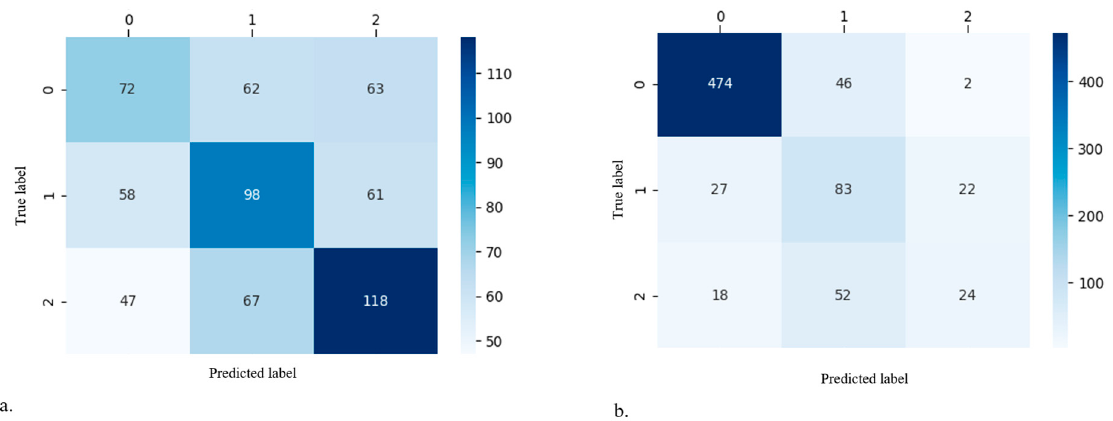
Figure 2. Confusion matrices of the best average precision model. ( a ) Progression rate of no or mild OA patients, and ( b ) fate of no or mild OA patients.